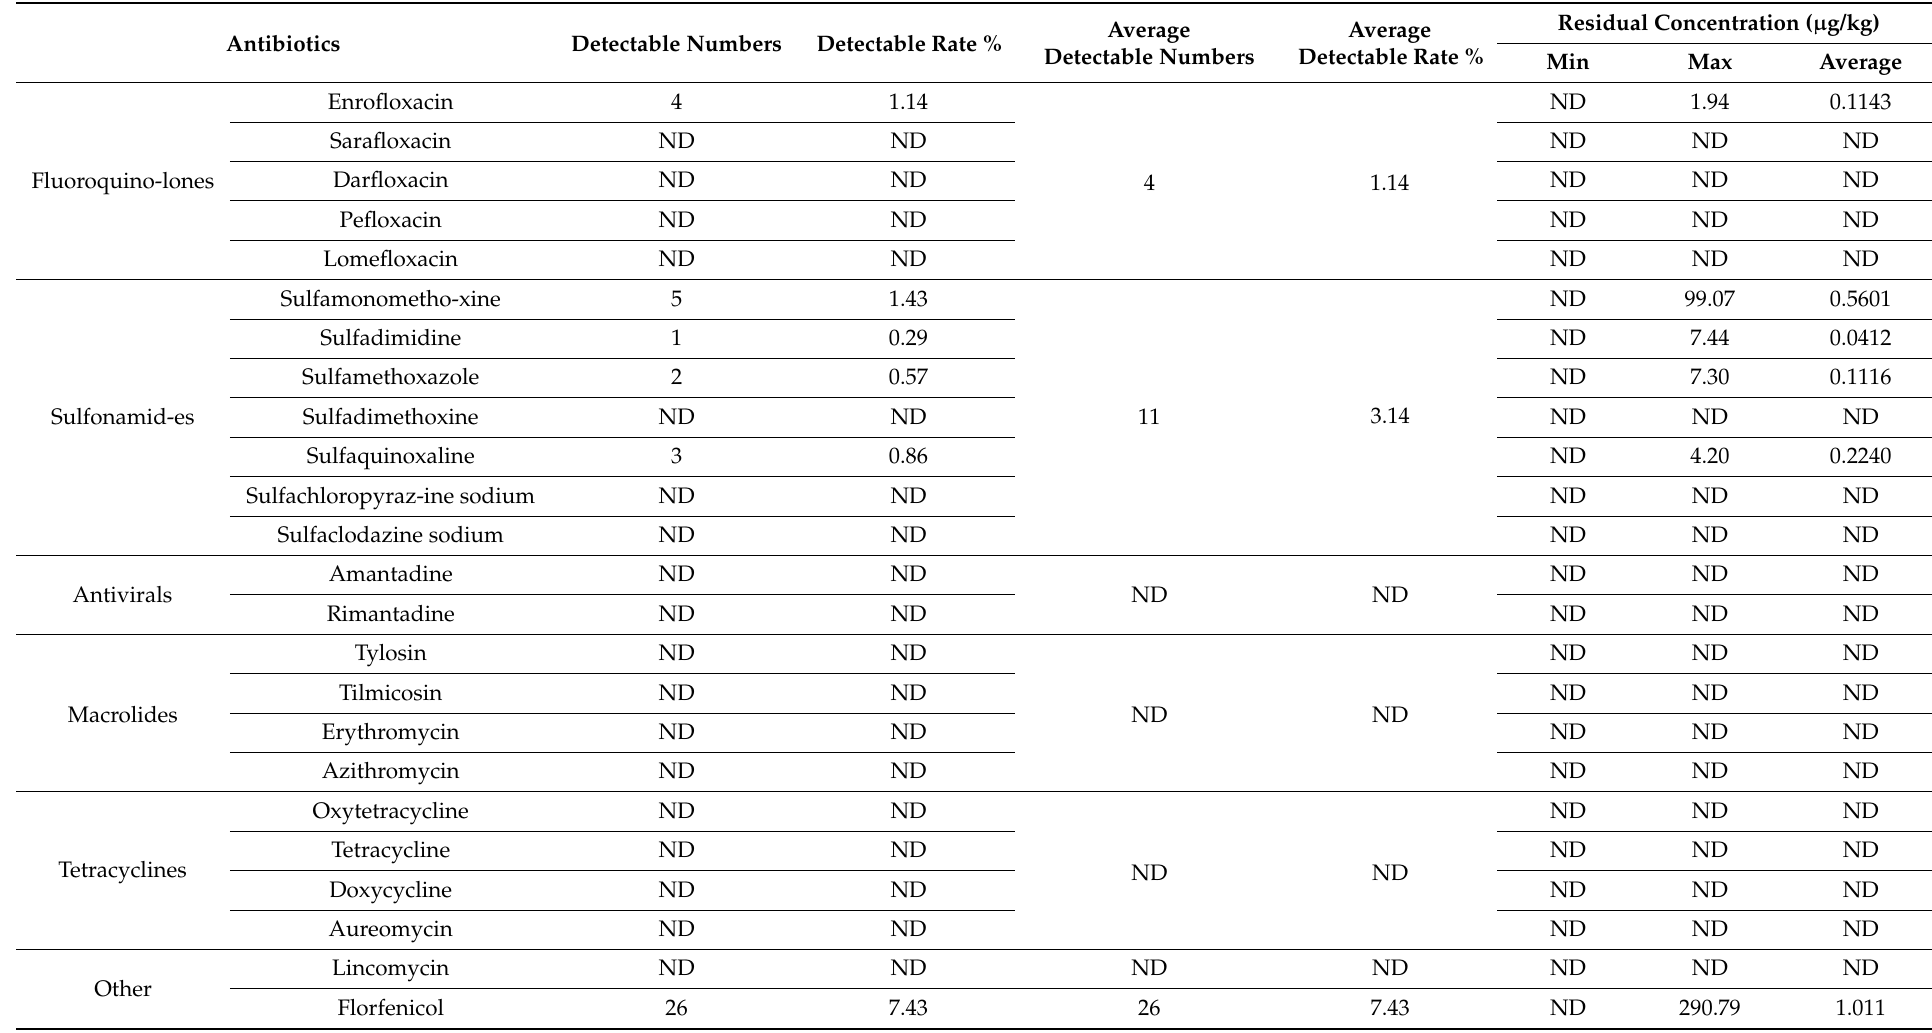
Table 4. Residues of antibiotics in eggs in